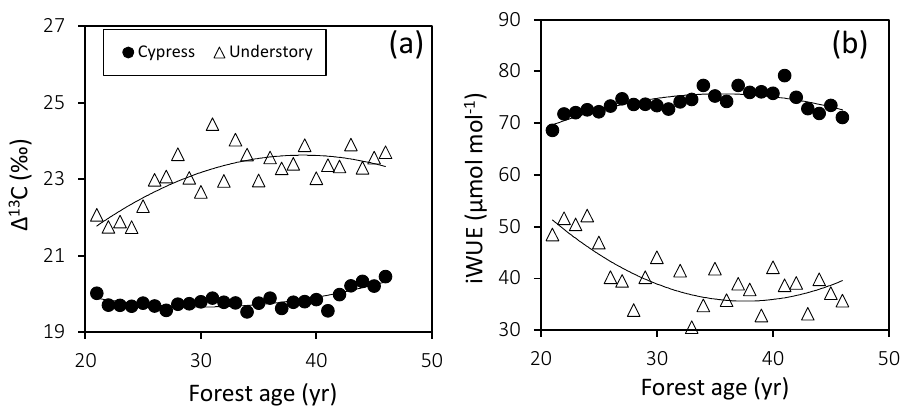
Figure 4. Carbon discrimination ( ∆ 13 C) ( a ) and intrinsic water-use efficiency (iWUE) ( b ) of hinoki cypress and understory vegetation in relation to forest age.